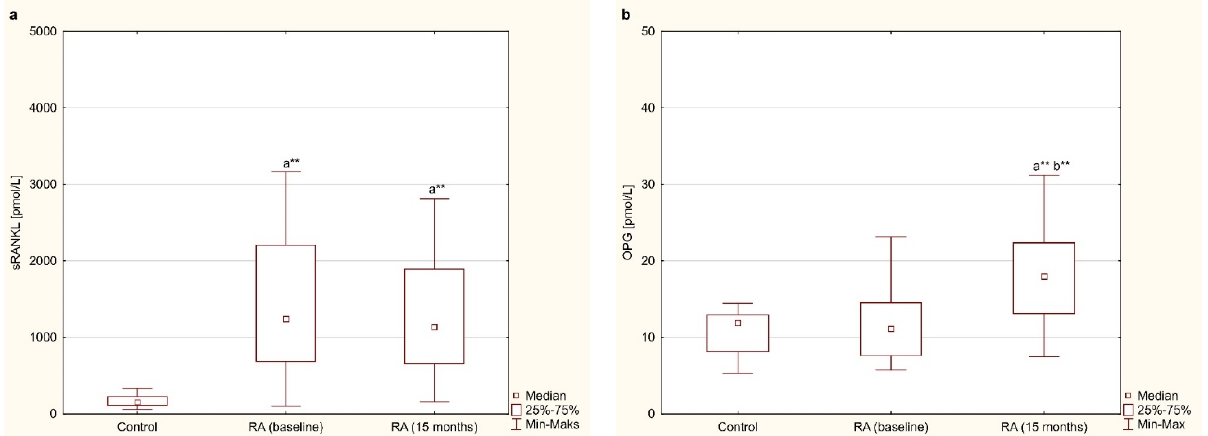
Figure 3. Effect of a 15-month TNF α I therapy on markers of osteoclastogenesis: sRANKL ( a ) and OPG ( b ) in women with rheumatoid arthritis, and in healthy women. a ** p < 0.001 compared to the control, b ** p < 0.001 compared to the baseline. OPG, osteoprotegerin; RA, rheumatoid arthritis; sRANKL, total soluble receptor activator of nuclear factor κ B ligand; TNF α I, tumor necrosis factor α inhibitors.